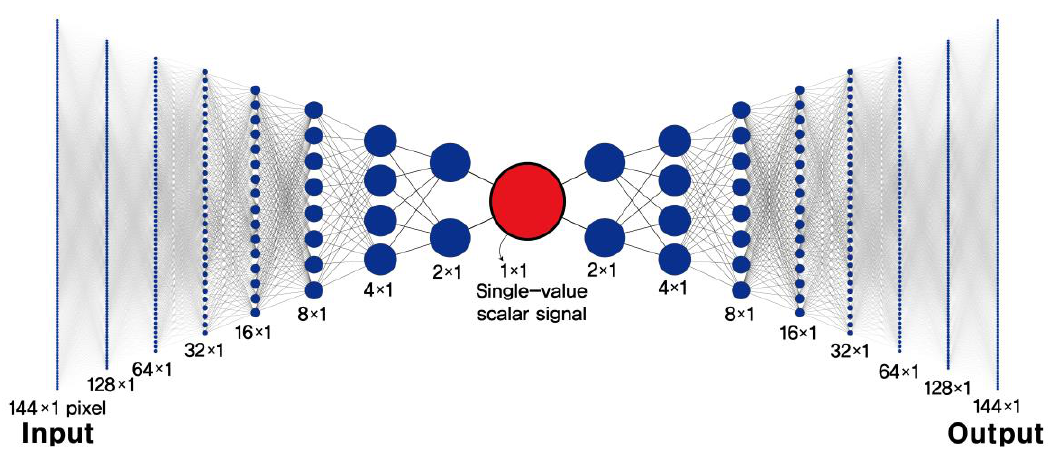
Figure 1. Architecture of the proposed autoencoder used to recognize the presence of a vehicle.